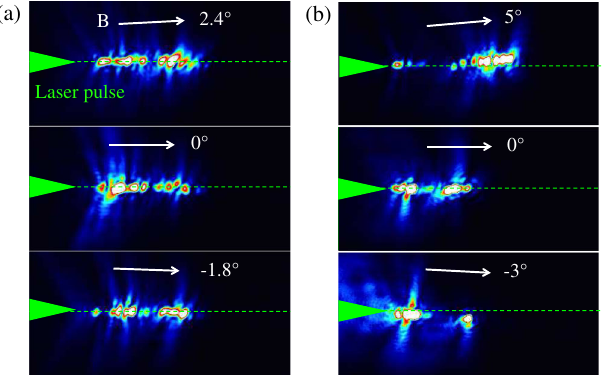
FIG. 3. Time-integrated images of Thomson scattering of laser pulse from the plasma with different tilting angles (a) in case of low-intensity prepulse (ASE level ∼ 10 11 W = cm 2 ) for the gas density ∼ 1 . 1 × 10 19 cm − 3 and (b) high-intensity prepulse (ASE level ∼ 10 12 W = cm 2 ) for the gas density ∼ 2 . 3 × 10 19 cm − 3